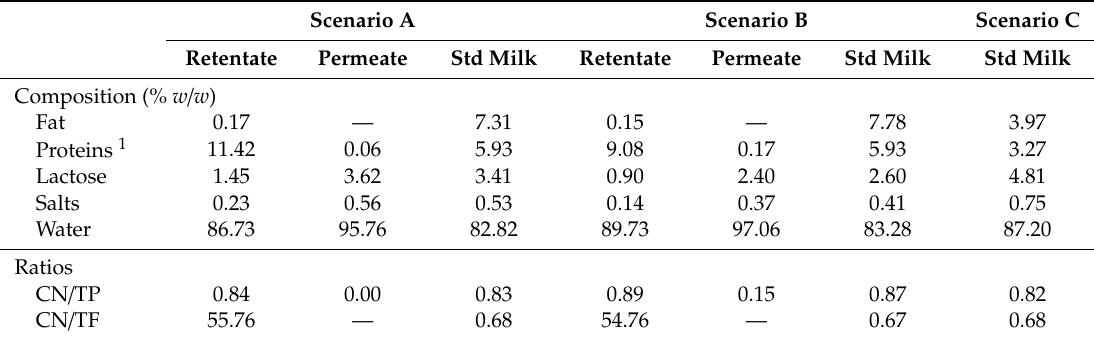
1 True Protein; Std milk: Standardized milk, CN / TP: Casein to true protein ratio, CN / TF: Casein to total milk fat